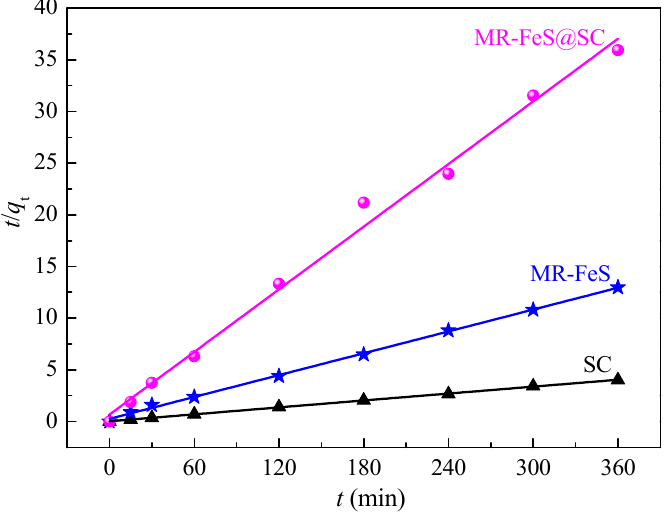
Figure 9. Pseudo-second-order kinetics for the adsorption of ST onto SC, MR–FeS, and MR–FeS@SC Figure 9. Pseudo ‐ second ‐ order kinetics for the adsorption of ST onto SC, MR – FeS, and MR – FeS@SC